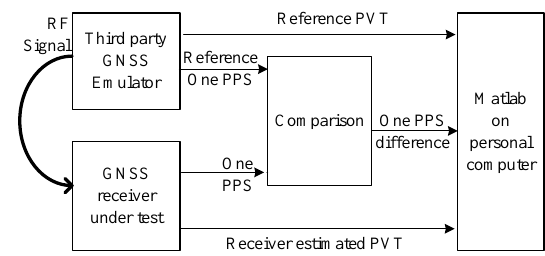
Figure 5. Hardware emulation setup.